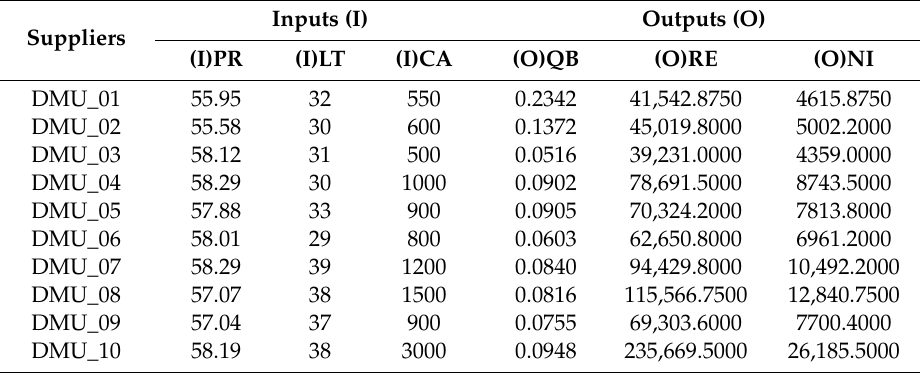
Table 8. Raw data of DEA